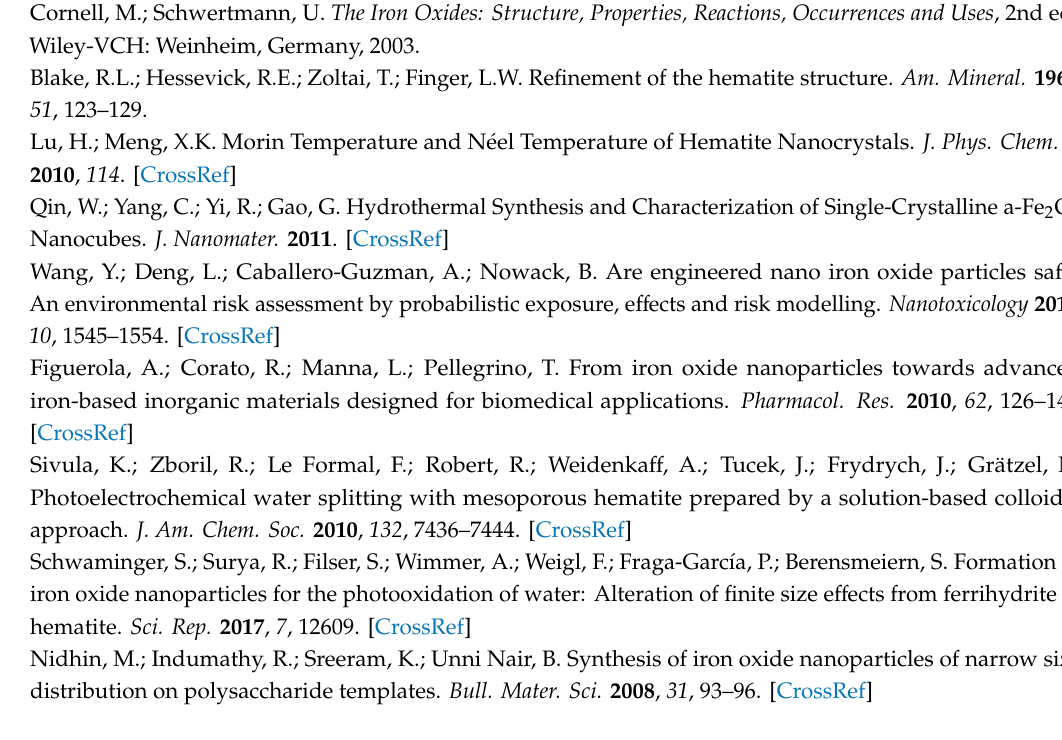
Figure S1: Chloride concentration (CC) values versus times during the exchange process, in relation to di ff erent initial chloride concentrations: ( a ) 0.1M, ( b ) 0.5 M and ( c ) 1 M., Figure S2: TG-DTA analysis at a heating rate of 10 ◦ C / min of lyophilized powder from Fh 1M sample, Figure S3: FESEM micrographs obtained on standard stabs (suspension concentration of 10 g / L), at 200kX magnification for di ff erent samples: ( a ) Fh 0.1M , ( b ) Fh 0.5M , ( c ) Fh 1M , ( d ) Fh 1Mfast , Figure S4: ATR-FTIR spectra from 400 to 4000 cm − 1 of the samples: just synthetized (Fh 1M ), aged two months at RT (H RT2 ), aged seven months at RT (H RT7 ) and calcined at 500 ◦ C (H 500